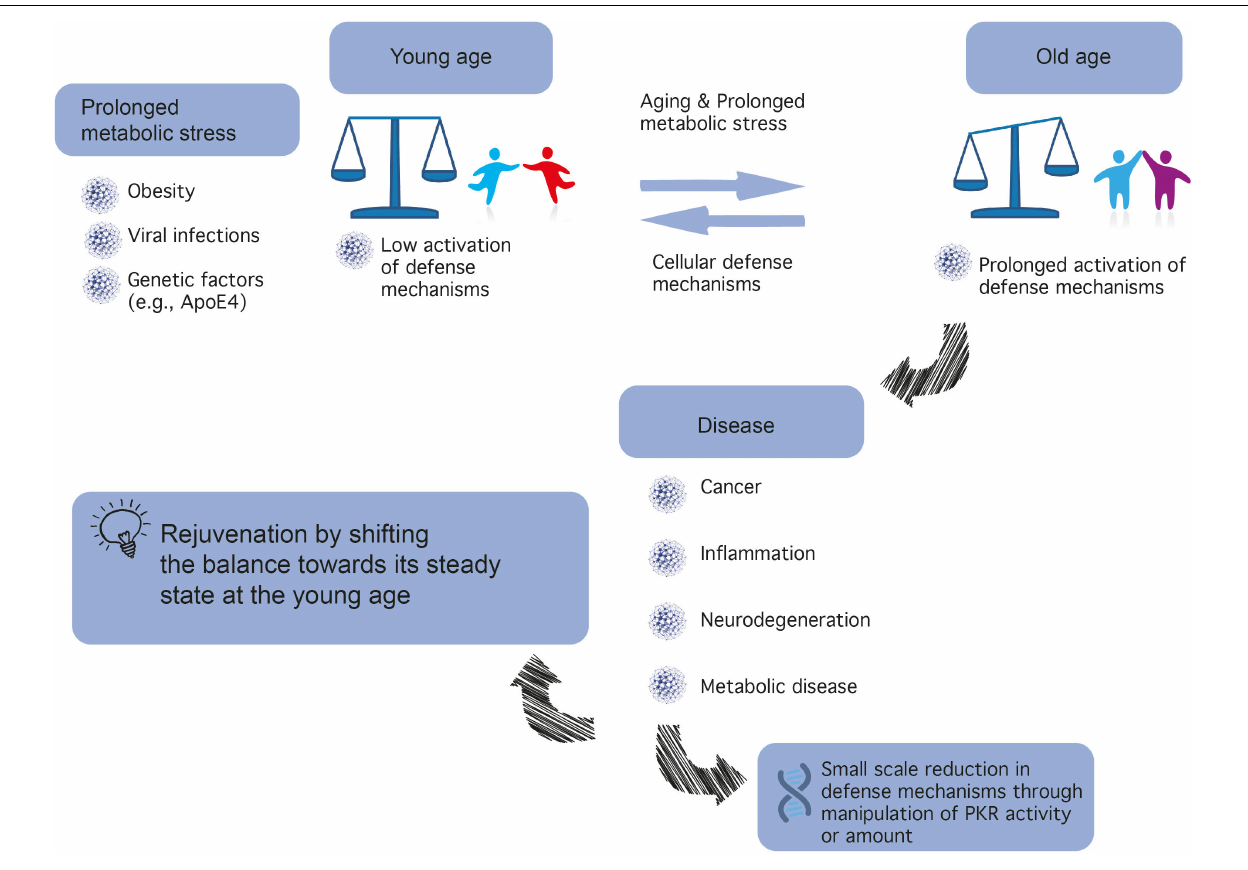
FIGURE 1 | A different balance in defense mechanisms exists in different cells. The development of novel PKR inhibitors differing in properties (e.g., affinity, reversibility) may be advantageous for the treatment of different types of cancer, brain diseases, inflammatory, and metabolic